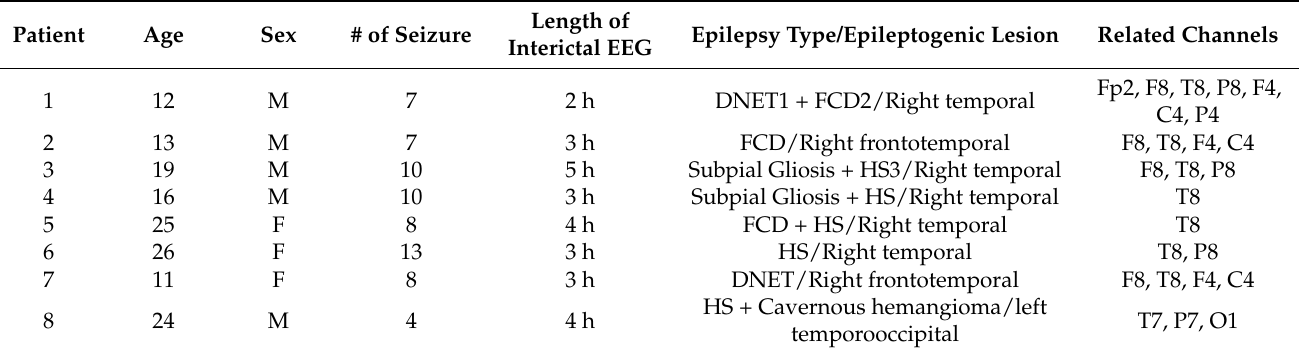
Table 2. Information on patients with epileptic